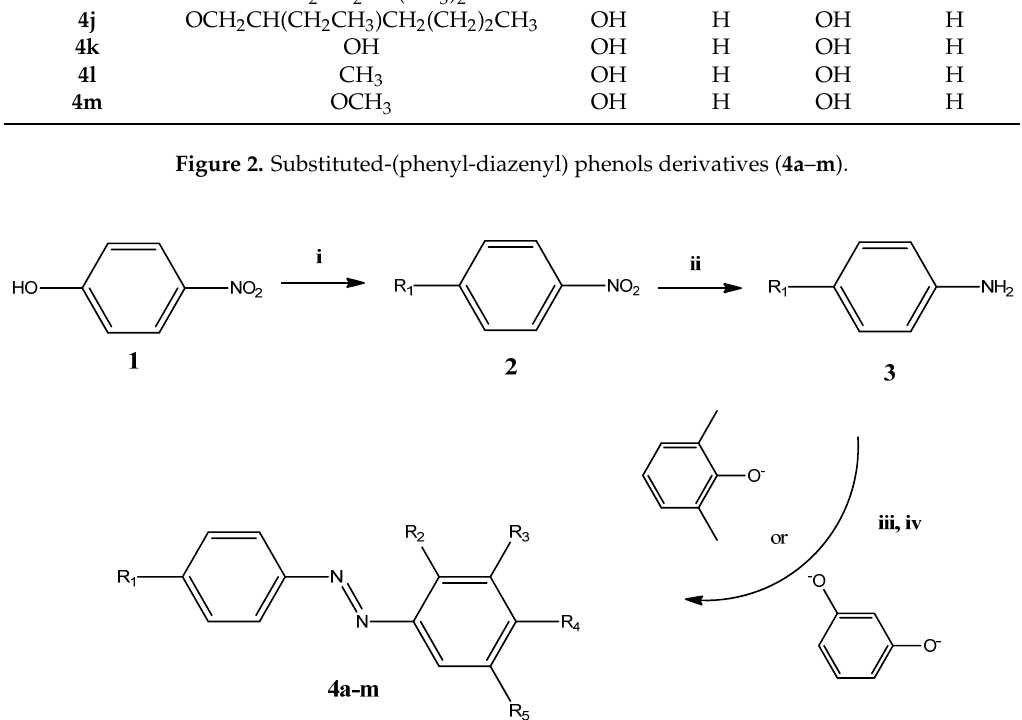
2 CO 3 , DMF reflux, 3 h; ii : SnCl 2